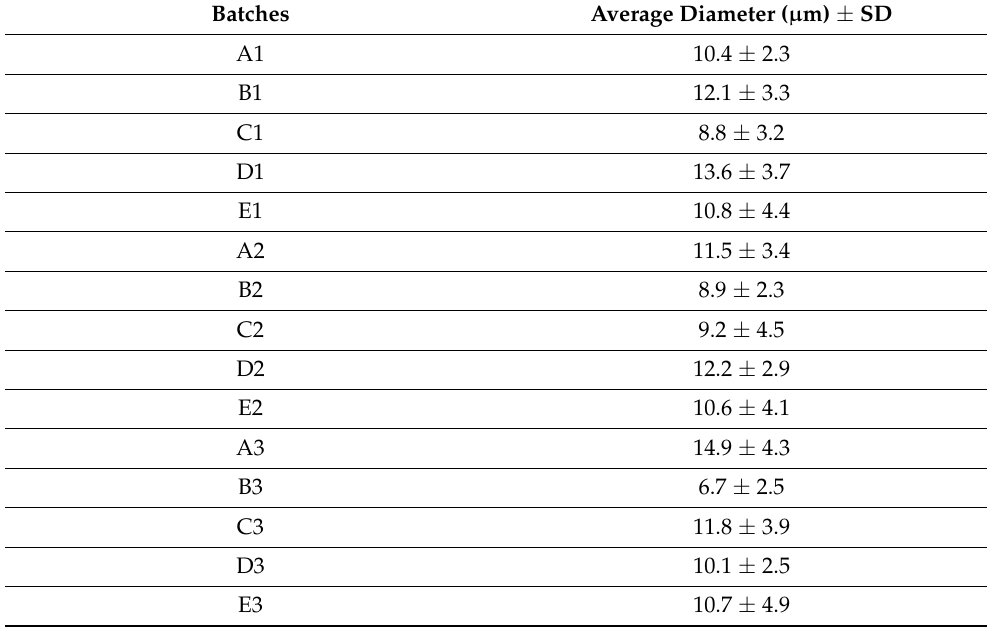
Table 2. Average diameter ( µ m) ± SD (mean ± SD, n = 3) for each batch of microparticles (A1, B1, C1, D1, E1, A2, B2, C2, D2, E2, A3, B3, C3, D3,